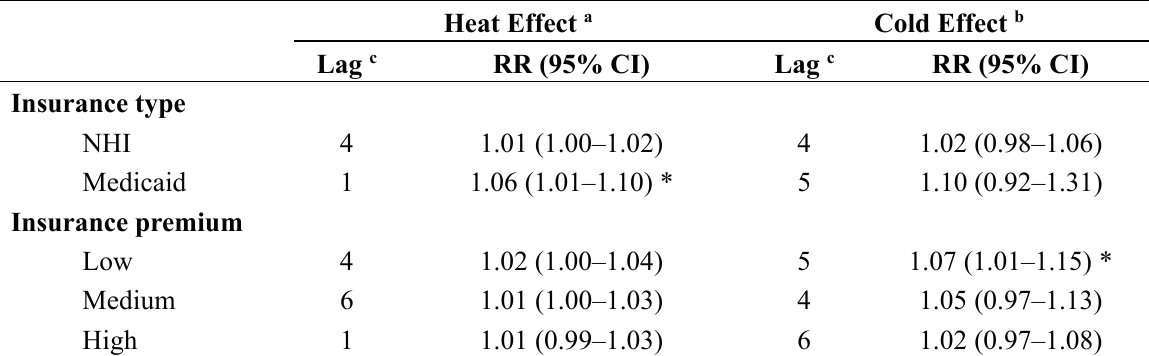
Table 6. The relative risk (RR) of heat and cold effects on AMI hospital admissions in warm weather period by insurance type and